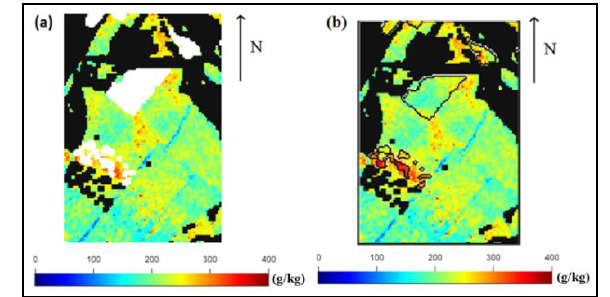
Figure 7: Clay mapping over HyMap test image, a) white pixels correspond to bare soil pixels, b) bare soil pixels are fulfilled using clay content estimated by the PLSR model [1]. Black areas correspond to filtered pixels (CAI >